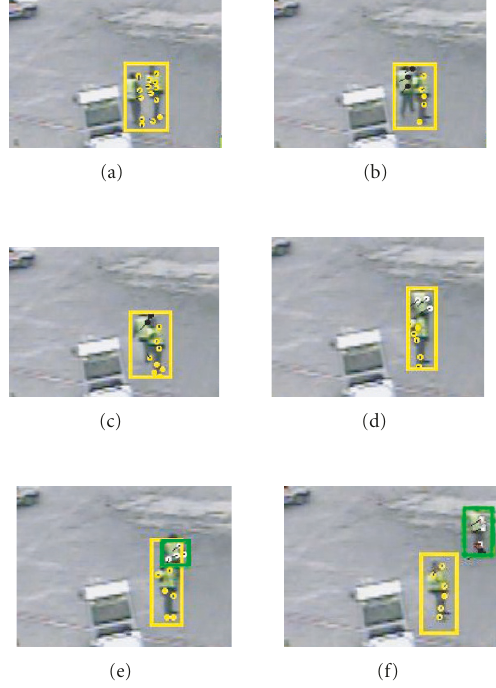
Figure 5: (a) Shows two quasi-stationary persons merged together, with their features highlighted in yellow and explained by a sin- gle motion model; (b)–(c) as the person on the left starts moving, the motion of its features (shown by black vectors) creates a sec- ondary motion model with initially low confidence (shown by black circles); (d) confidence in the secondary motion model increases (turning to white circles), until (e) splitting occurs and a new object is created; (f) the two persons are no longer